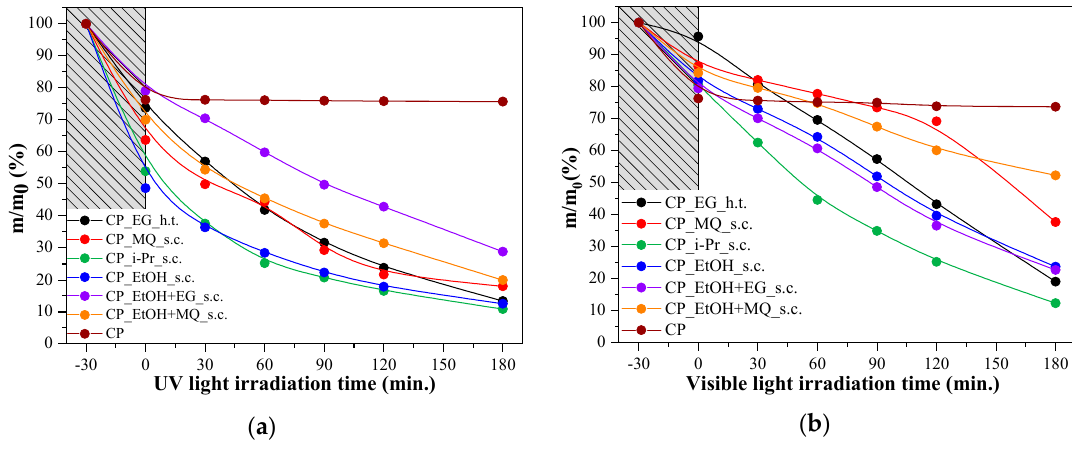
Figure 10. Rhodamine B photocatalytic degradation measurements under UV ( a ), and visible light irradiation ( b ) with an immobilized BiOI layer in a unique flow reactor.